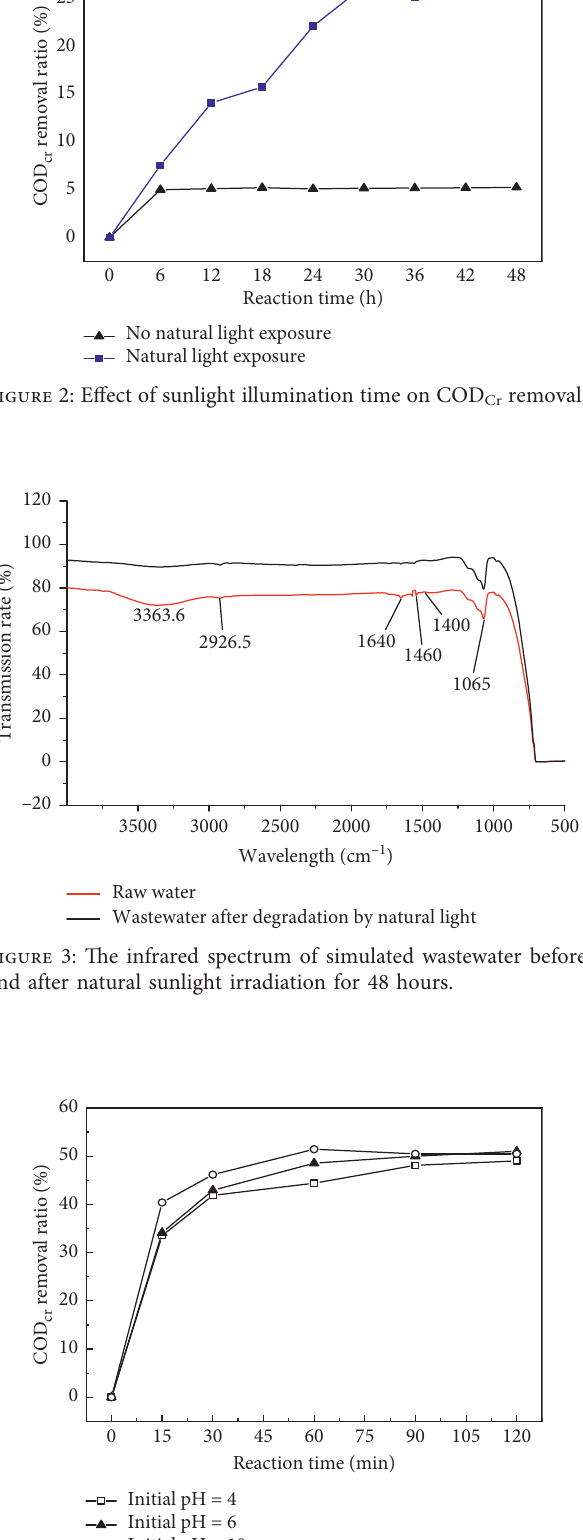
Figure 4: Effect of reaction time on COD